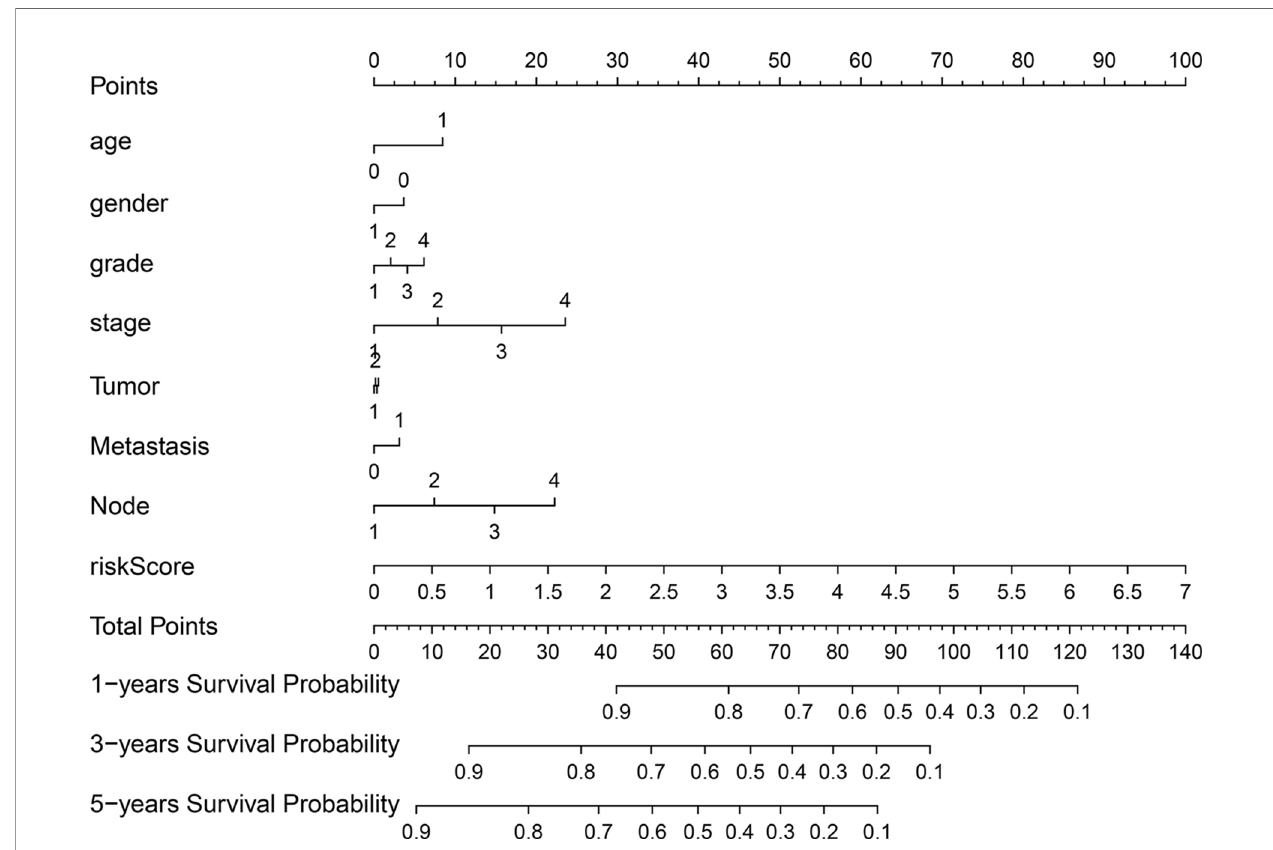
FIGURE 2 | Nomograph of 1-, 3-, and 5-year overall survival probabilities predicted based on autophagy-related LncRNA